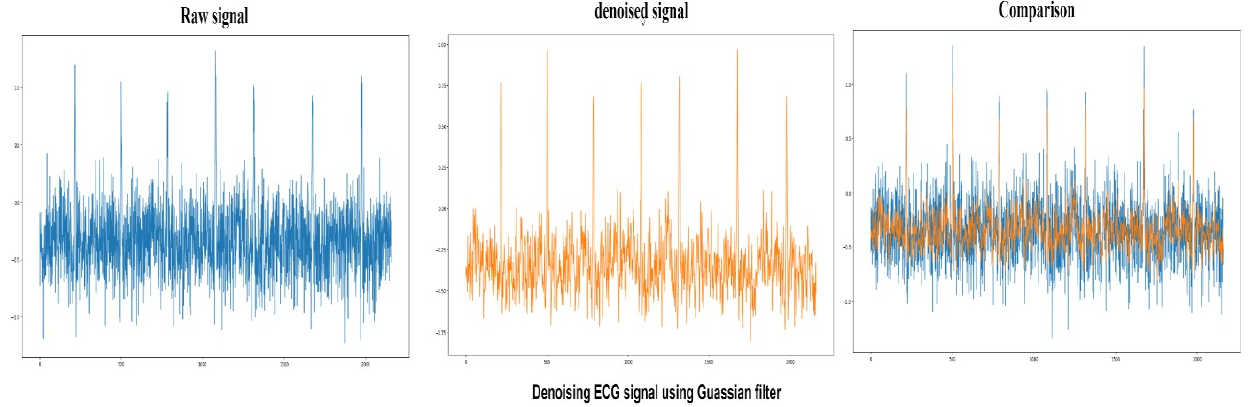
Figure 8. Raw ECG signal (Blue) denoising using Gaussian filter and comparison between denoised (Orange) and raw signals.